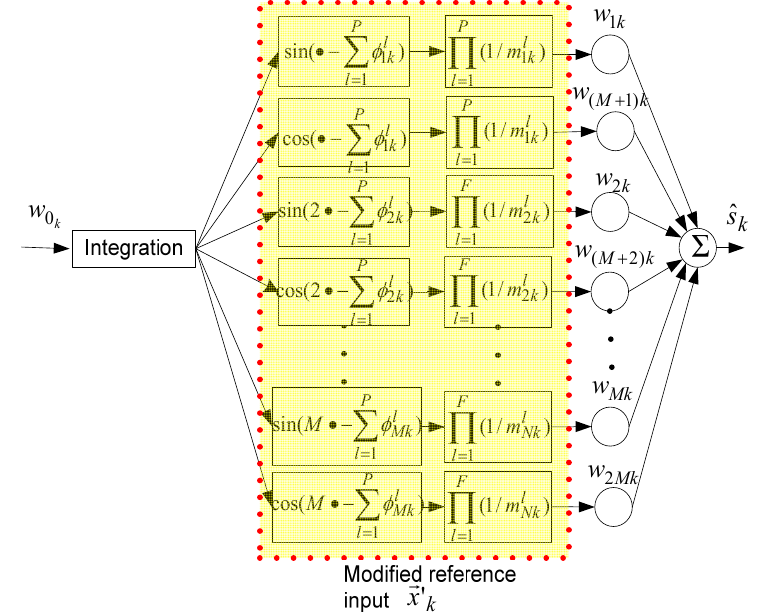
Figure 4. The block diagram of the compensation using the modified reference input in